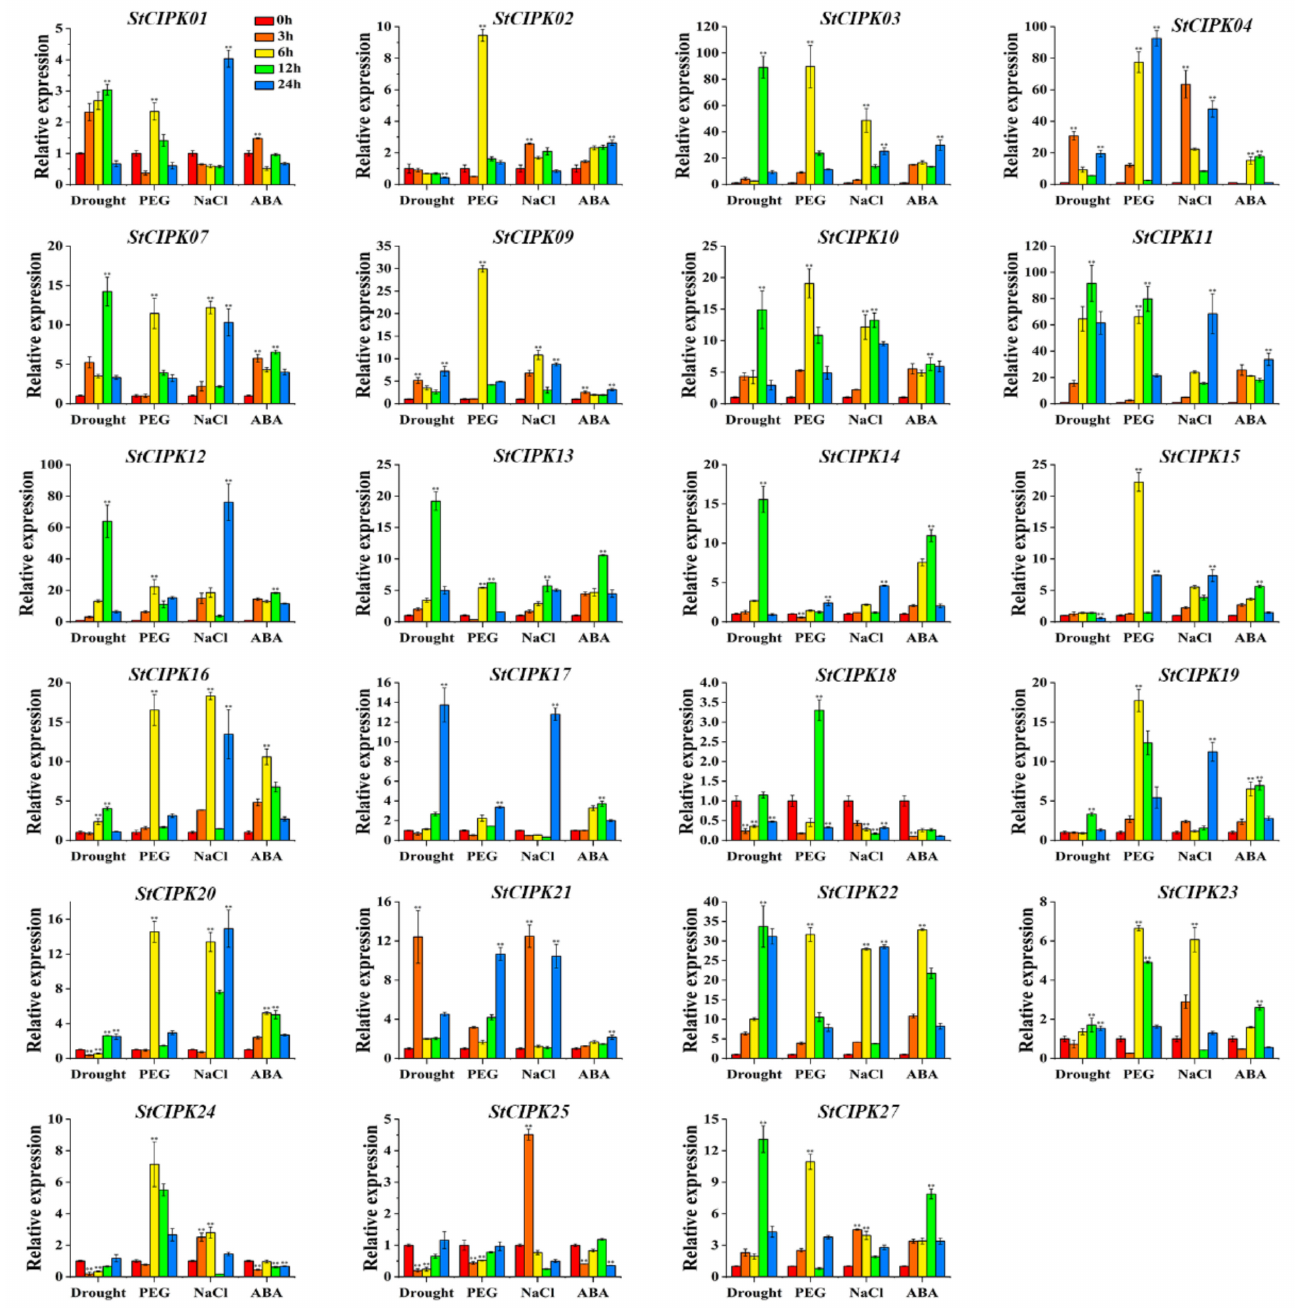
Figure 3. Expression profiles of StCIPK genes in response to drought, PEG and salt stresses and ABA treatment. Data are mean ± SD ( n = 3). Significance compared with 0 h was determined using the ANOVA Duncan’s test; p < 0.01, highly significant